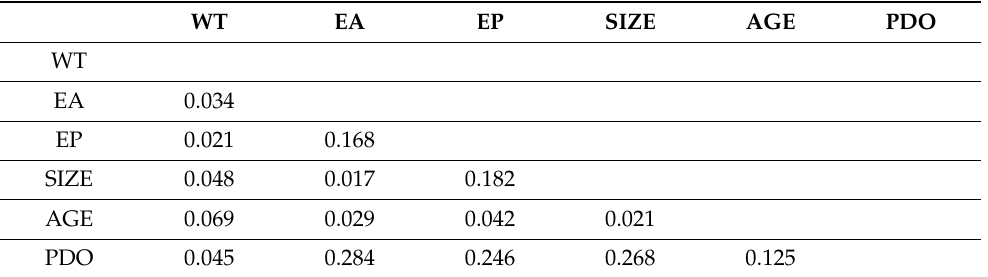
Table 4. Discriminant validity analysis based on the HTMT criterion.